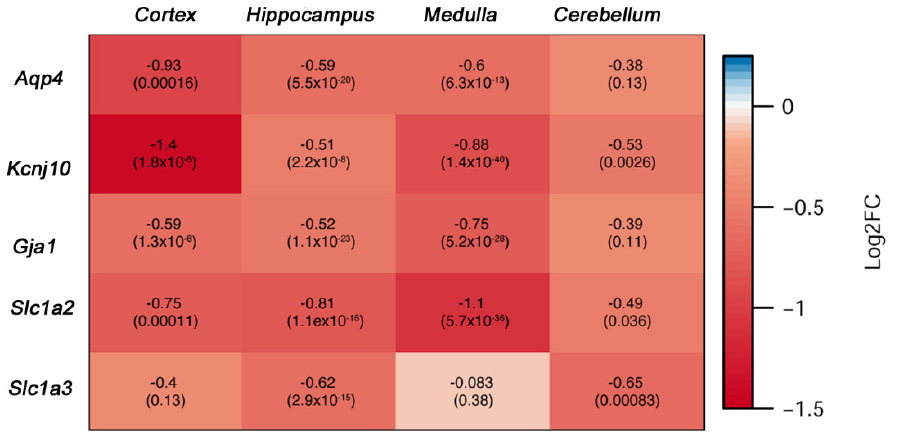
Figure 5. Late SCA1 stage astrocyte molecular analysis indicates brain-wide loss of core homeostatic functions. Cerebellum, brainstem (medulla), hippocampus, and cortex were isolated from 26 weeks old Atxn1 154Q/2Q and wild-type control mice (N = 4 of each genotype) and isolated RNA was sent for RNA-sequencing (RNA-seq). Expression of astrocyte genes was determined using differential gene expression analysis with numbers in each square representing log2 fold change (log2FC) in Atxn1 154Q/2Q compared to wild-type controls and numbers in brackets presenting False Discovery Rate adjusted p values.